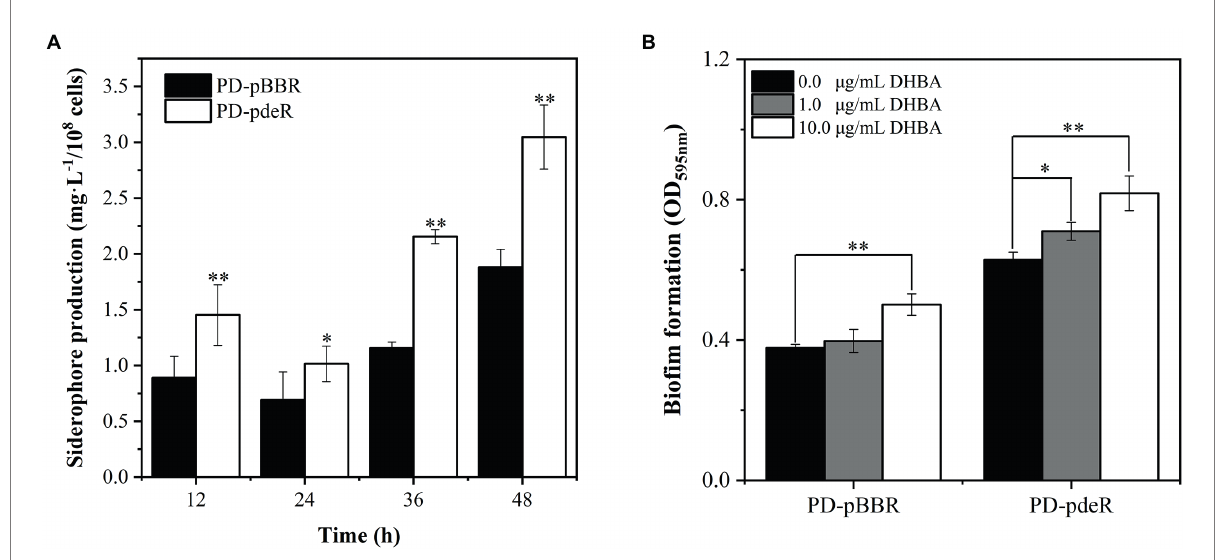
FIGURE 9 (A) Detection of siderophore production of PD-pBBR (black bar) and PD-pdeR (white bar) using Arnow test after 12, 24, 36 and 48 h incubation, respectively. (B) The effect of DHBA addition on biofilm formation. The addition concentrations of DHBA were 0, 1 and 10 μ g/ml, and biofilm was detected after 36 h incubation. Data are presented as mean ± SD, n = 3. * p < 0.05, ** p < 0.01 compared with the negative control